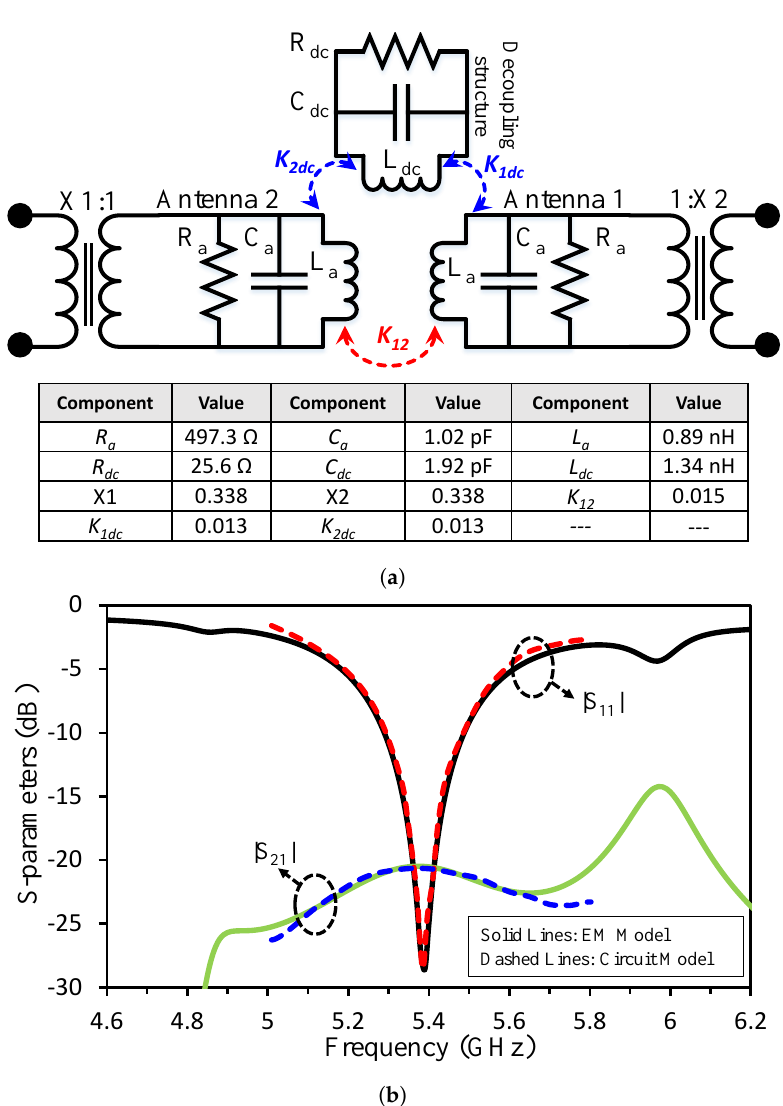
Figure 6. ( a ) Equivalent circuit model of the two-element MIMO antenna with decoupling structure, and ( b ) S-parameters comparison of the EM model (solid lines) and circuit model (dashed